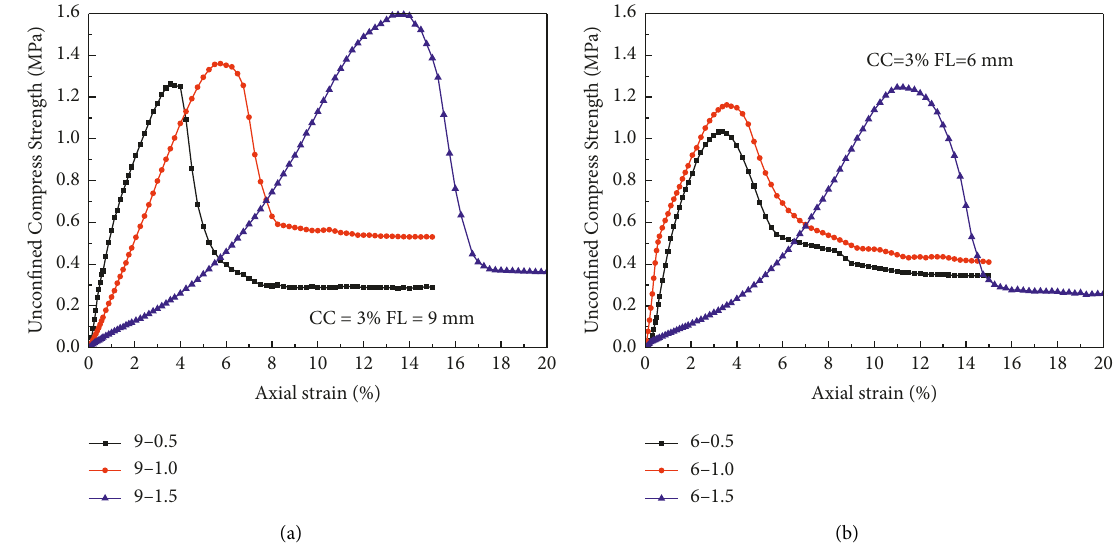
Figure 8: Relationship between unconfined compressive strength and axial strain (a) Fiber length � 9 mm. (b) Fiber length � 6